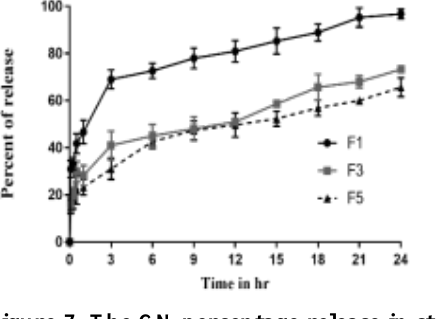
Figure 7. The CN percentage release in stomach solutions pH 1.2 from selected concentrations of HOA/SO